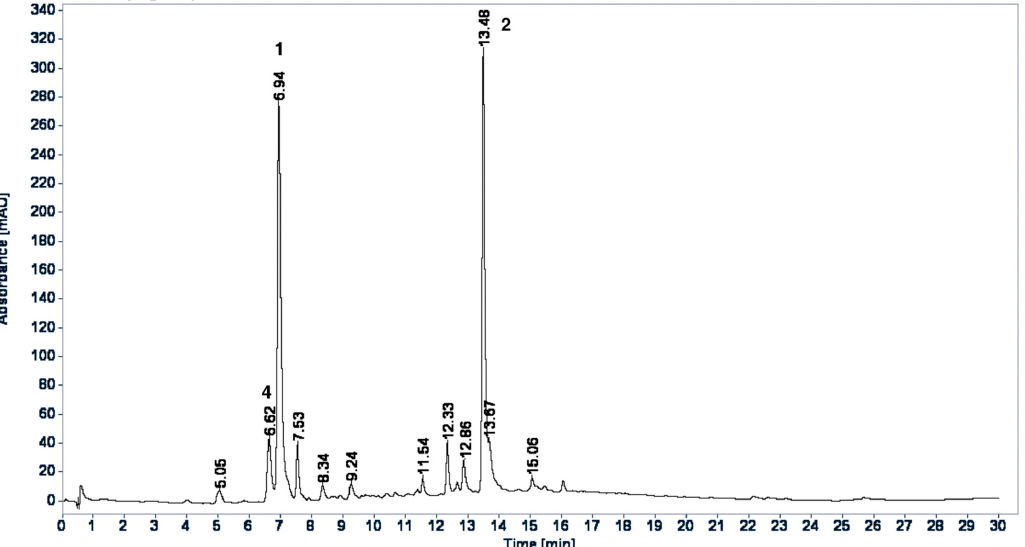
Figure 3. HPLC ‐ DAD profile of water extract of E. cymosum ; acquisition of λ 320 nm. Phenomenex ® Kinetex C 18 (Phenomenex Inc., Torrance, CA., USA) 100 Å (50 × 2.1 mm id., 5 μ m) reversed ‐ phase column; the column temperature was kept at 35 °C; the flow rate was 0.35 mL/min; elution was carried out with water containing 0.1% ( v / v ) formic acid and acetonitrile (MeCN), as described in the experimental section.